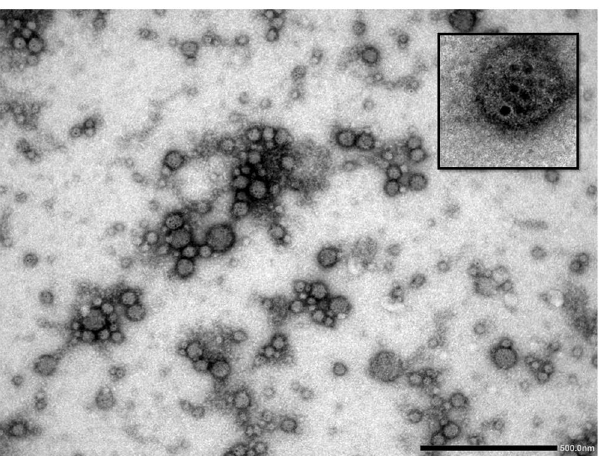
Figure 2. TEM image of negatively stained ASNPs with magnification of 50000 (insert image magnification: 100000).